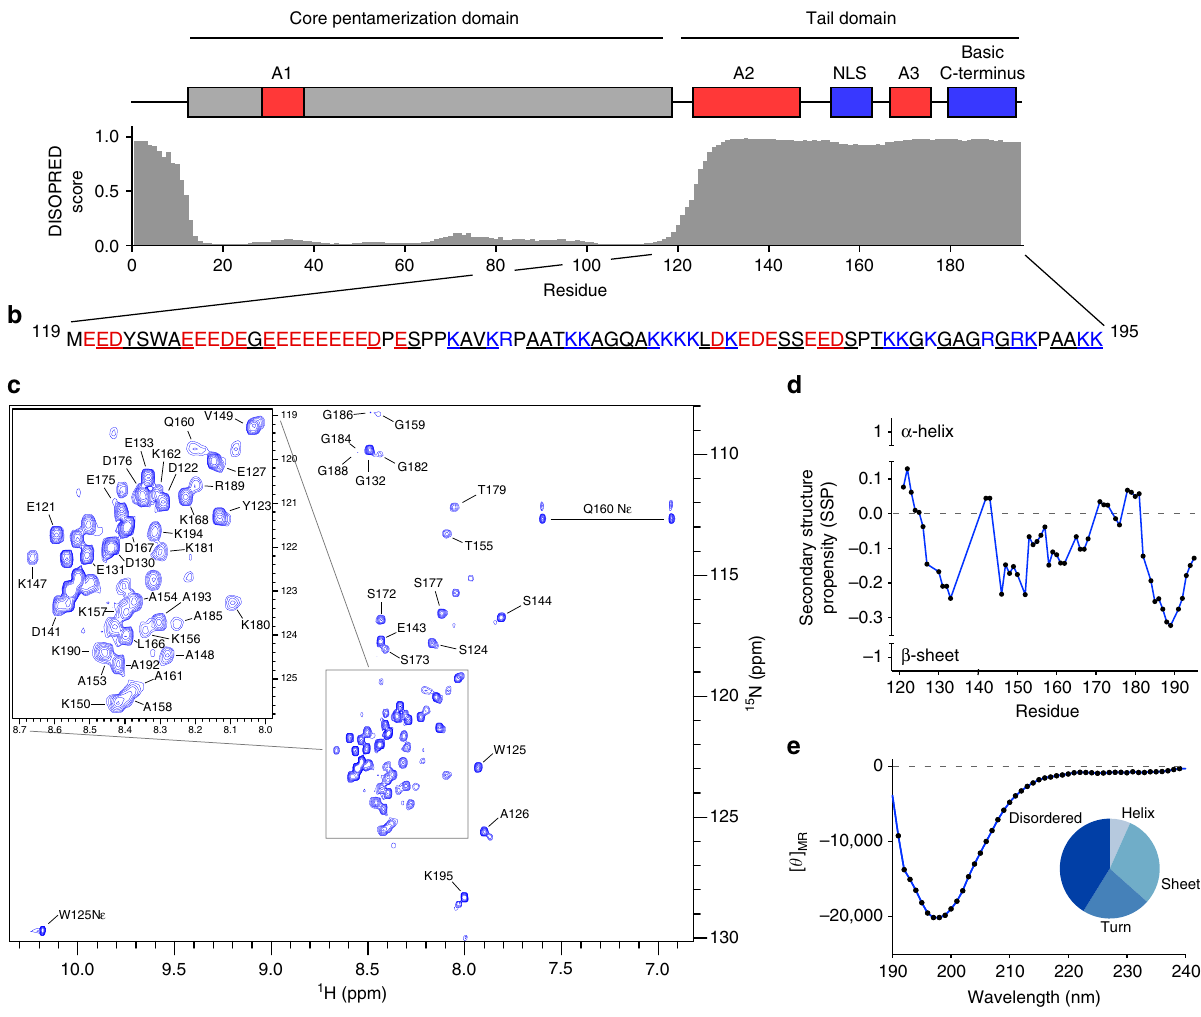
Fig. 1 Transient structural states of the Npm tail domain detected by NMR. a Domain layout of Xenopus laevis Npm. Core domain is colored gray, acidic stretches (A1, A2, and A3) colored red, basic NLS and C-terminus colored blue. Disorder prediction of Npm by DISOPRED3 software (0 = ordered, 1 = disordered). b Sequence of the Npm tail domain (residues 119 – 195). Acidic and basic residues colored red and blue, respectively. Underlined residues are assigned in the 1 H- 15 N HSQC spectrum. c 1 H- 15 N heteronuclear single quantum coherence (HSQC) spectrum of the Npm tail domain. d Secondary structure propensity (SSP) plot of the Npm tail domain derived from C α , C β , and H α chemical shift values. +1 indicates a stable α -helix, − 1 indicates a stable β -sheet. e Circular dichroism (CD) spectrum and CONTIN secondary structure analysis of the Npm tail